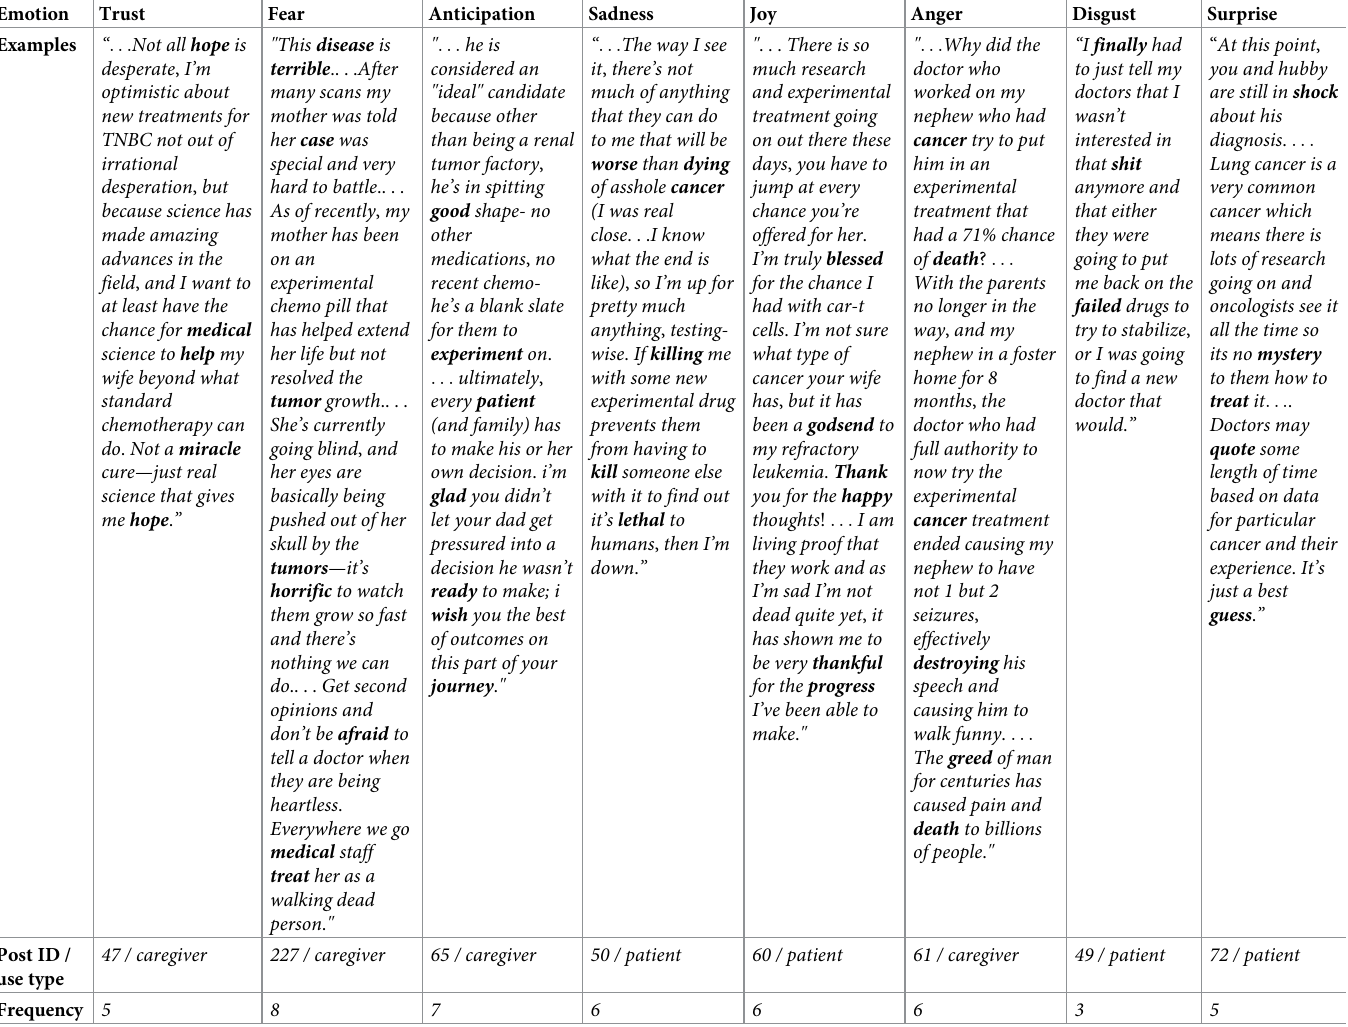
Table 4. Extracts from posts representing the emotions. Emotion Trust Fear Anticipation Sadness Joy Anger Disgust Examples “ ... Not all hope is desperate , I’m optimistic about new treatments